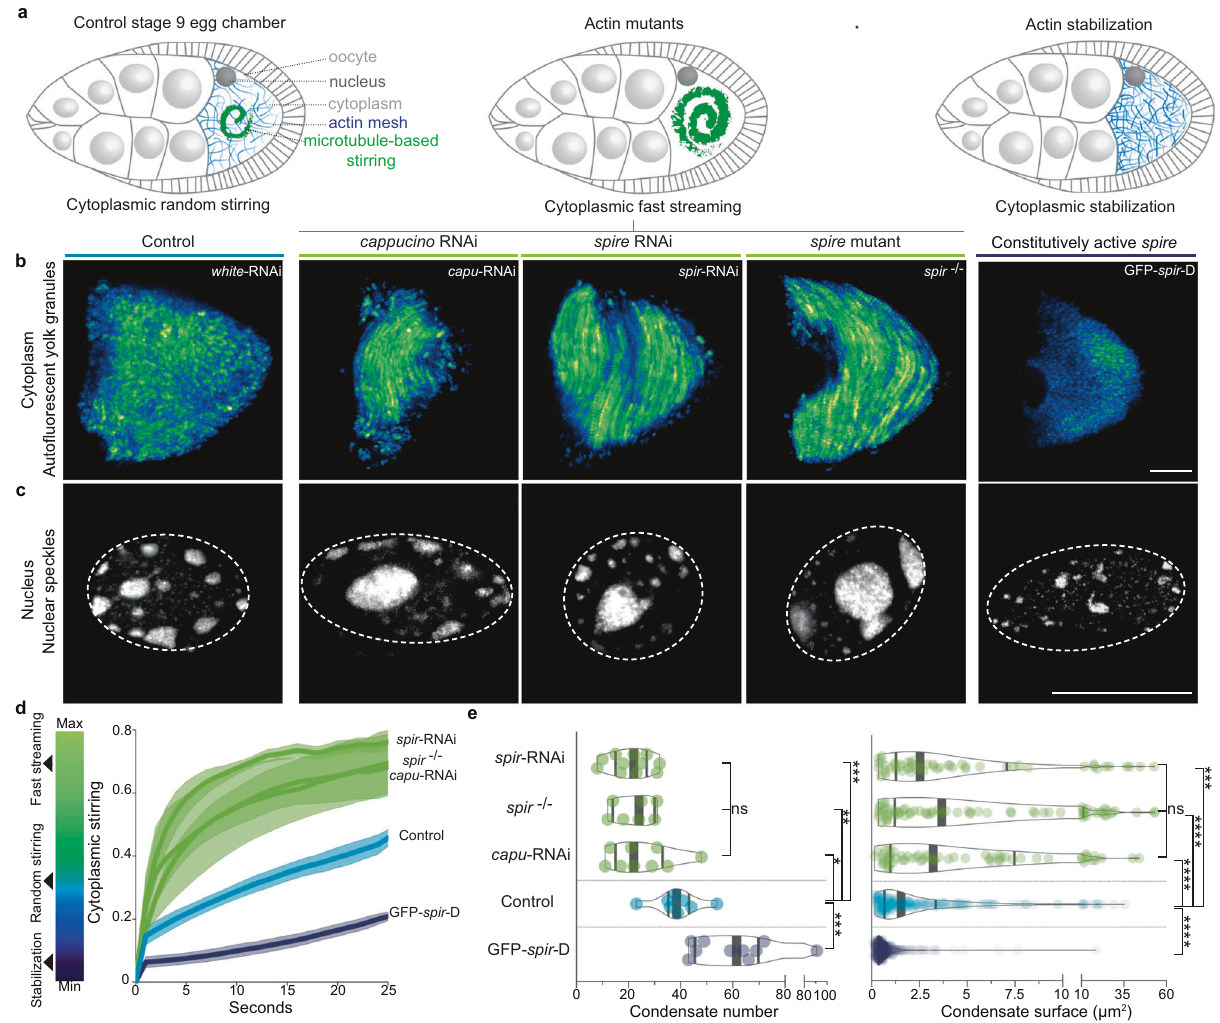
Fig. 6 | Cytoplasmic aptitude to reorganize nuclear condensates is evolutio- narily conserved in insects.a Illustrations of Drosophilamelanogaster stage 9 egg chambers composed of the oocyte surrounded by a nurse and follicular cells. At stage 9, cytoplasmic random stirring occurs in controls (left), premature microtubule-based fast streaming in actin mutants (center), and stabilization in mutants with constitutively active actin nucleators (right). b Time-projections of cytoplasmic stirring viewed with auto fl uorescent yolk granules in Control, cap- puccino , and spire mutants, or constitutively active spire overexpression mutants (GFP- spir -D); single z-slice time-projections of 25s shown with “ GFB ” LUTs. c Immunoreactivity of speckles in nuclei of oocytes with Control cytoplasmic ran- dom stirring, ampli fi ed fast streaming, or stabilization; 2 μ m z-projections with